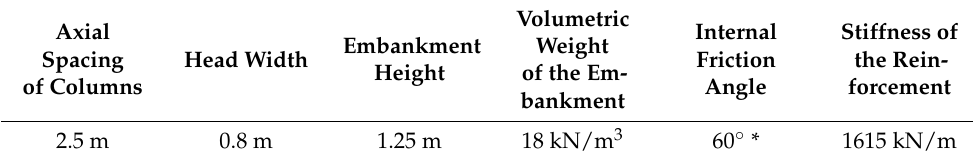
Table 2. Parameters used in the analysis related to the presented